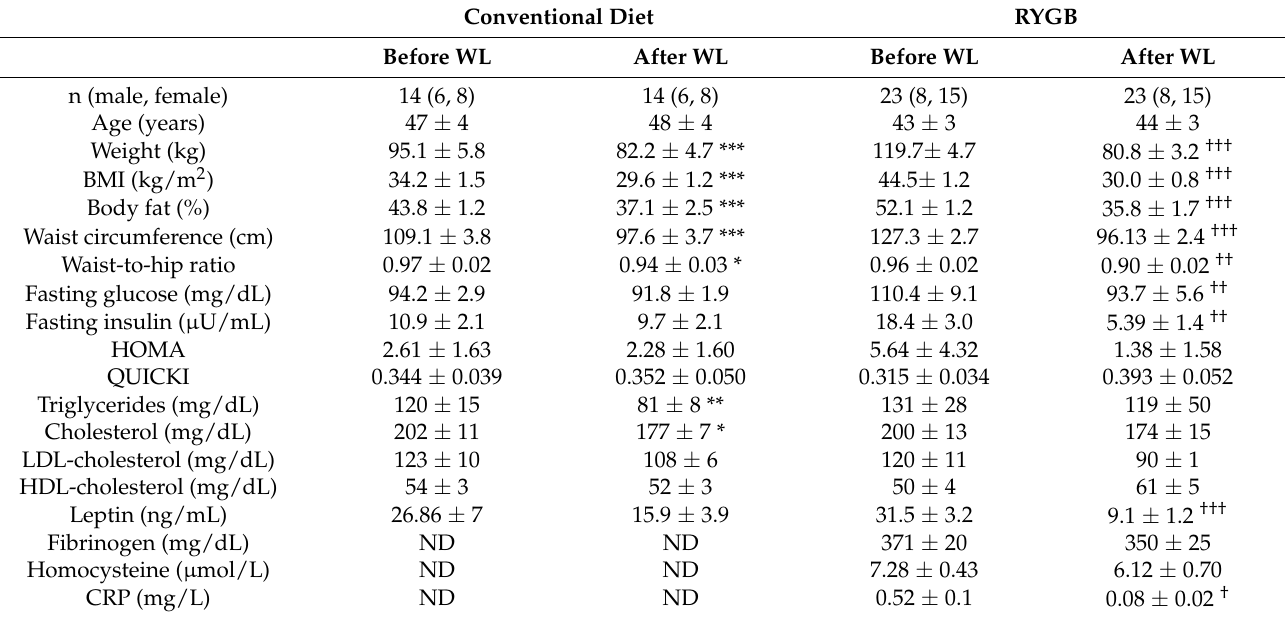
Table 3. Effects of weight loss in patients with OB after conventional diet and Roux-en-Y gastric bypass. Conventional